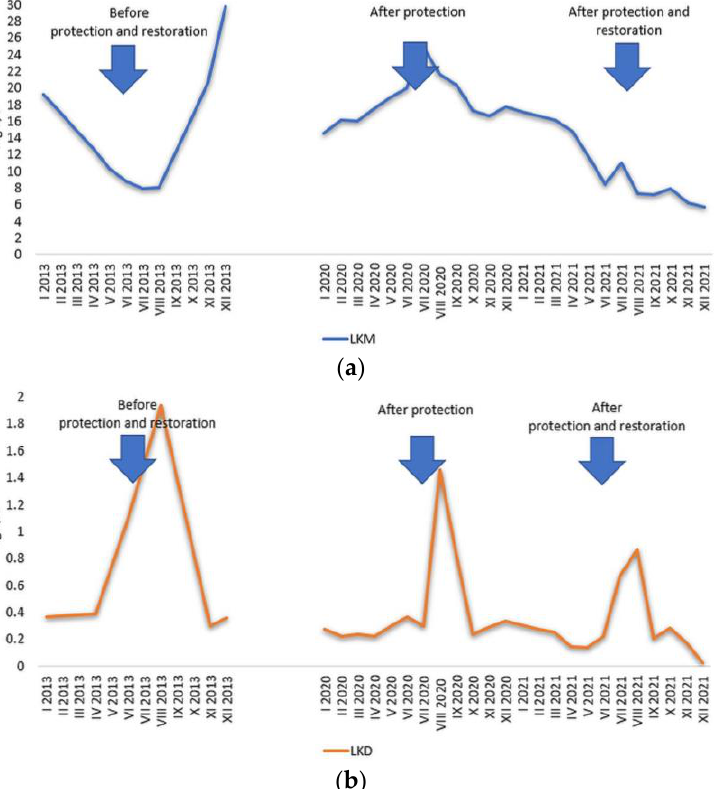
Figure 14. ( a ) Changes in the content of TP in the bottom water layers of Lake Klasztorne Małe in selected research years. ( b ) Changes in the content of TP in the bottom water layers of Lake Klasztorne Duże in selected research years.